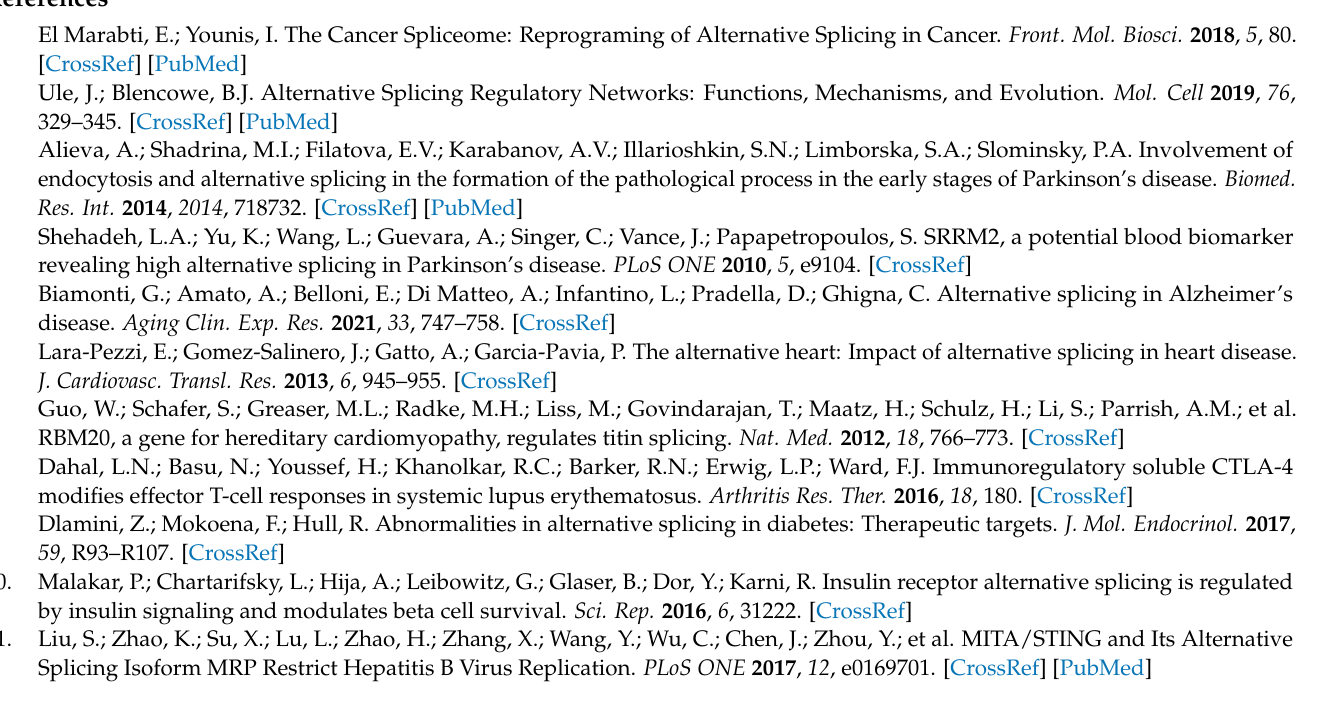
Lonp1 ISO1, ISO2, and ISO3 overexpression on mitochondrial